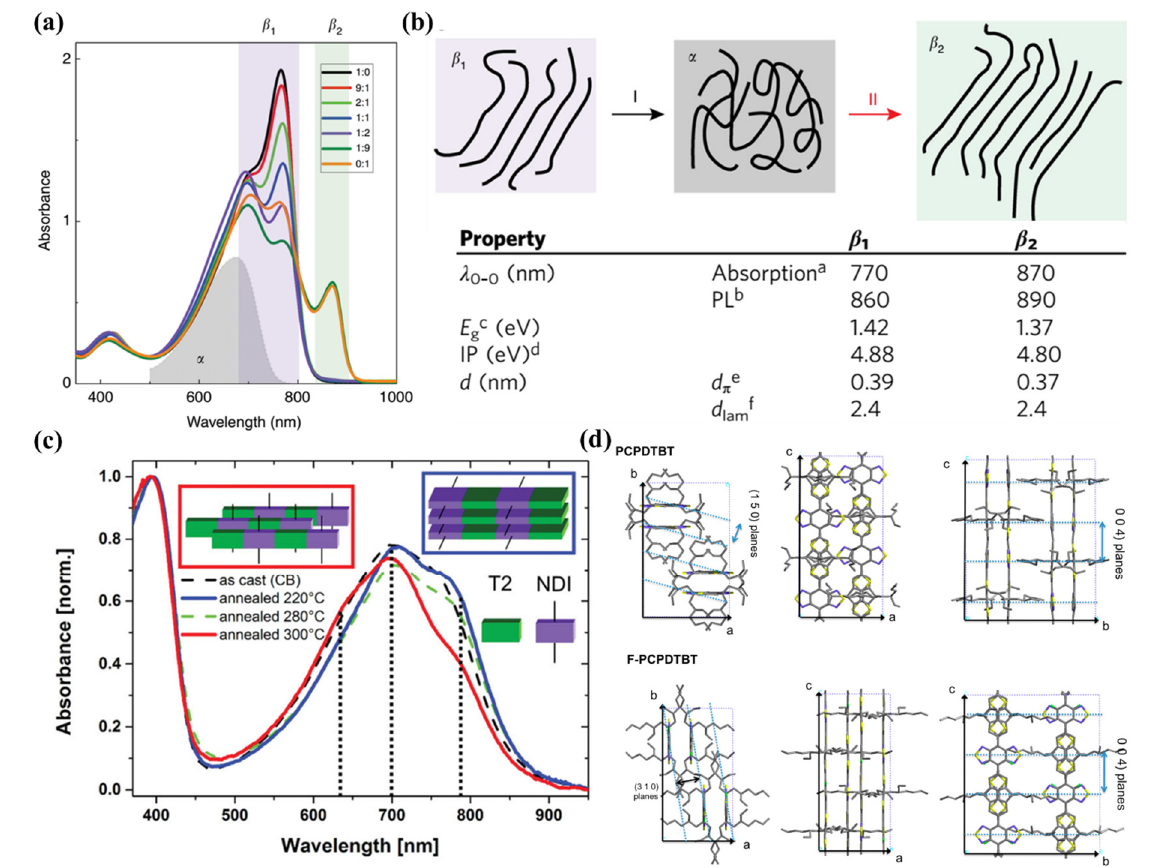
Figure 9. ( a ) UV-vis spectra of D-PDPP4T-HD dissolved in CF and TCB mixtures. ( b ) Schematic illustration and properties of the two polymorphs, which were adapted from reference [136] with permission from Copyright 2019 Nature Publishing Group. ( c ) UV-vis spectra of PNDI films melt- annealed at different temperatures, which were adapted from reference [137] with permission from Copyright 2014 Wiley. ( d ) The structural models of PCPDTBT and F-PCPDTBT crystals, which were adapted from reference [139] with permission from Copyright 2015 American Chemical